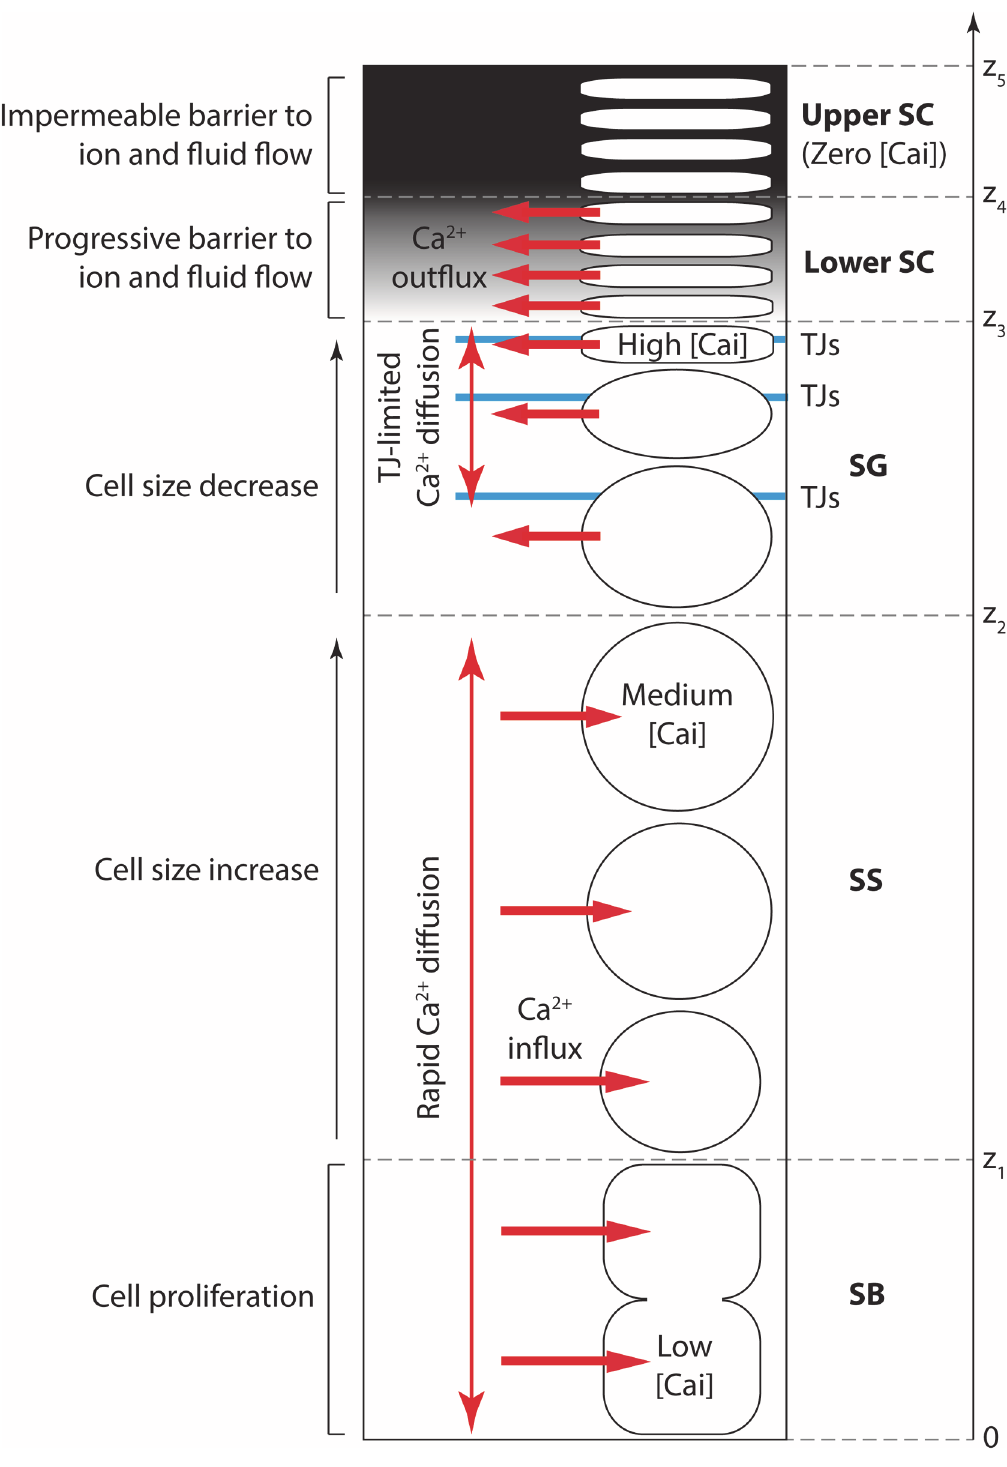
Figure 2. Proposed conceptual model of epidermal calcium profile formation in unwounded skin. The mathematical model presented in this paper simplifies the progressive barrier in the lower SC to a distinct barrier at the lower-upper SC boundary.